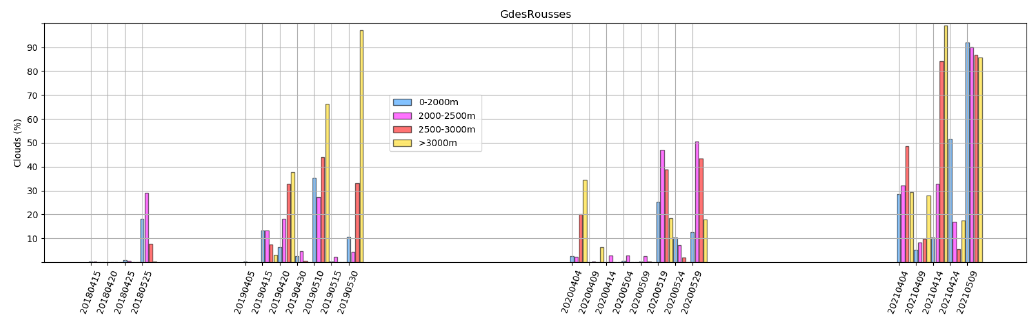
Figure 8. Cloud rates for selected Sentinel-2 observations (April–May). The results are shown by altitude range (blue squares: 0–2000 m, pink squares: 2000–2500 m, orange squares: 2500–3000 m and yellow squares: >3000